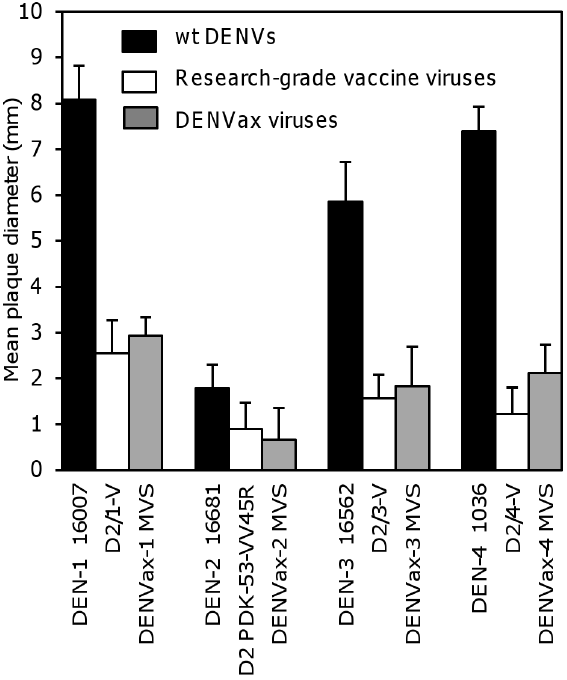
Figure 1. Plaque sizes of the DENVax MVS. Mean plaque diameters (mm) 6 SD (error bars) of the virus plaques in Vero cells under agarose overlay measured on day 9 pi. The wt DENVs and previously published research-grade vaccine candidate viruses were included for control and comparison.